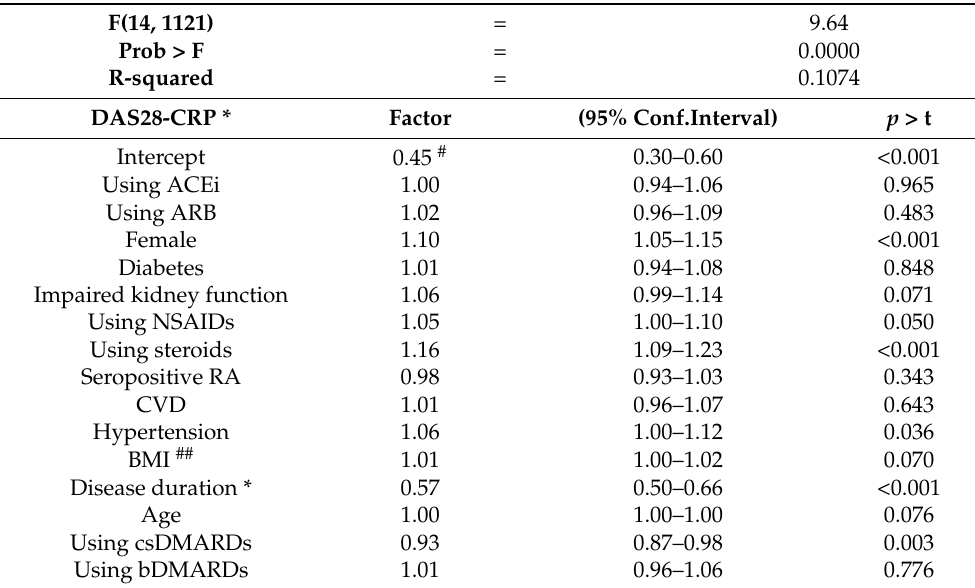
Table 2. Multiple linear regression of multiple confounders and the effect on the DAS28-CRP